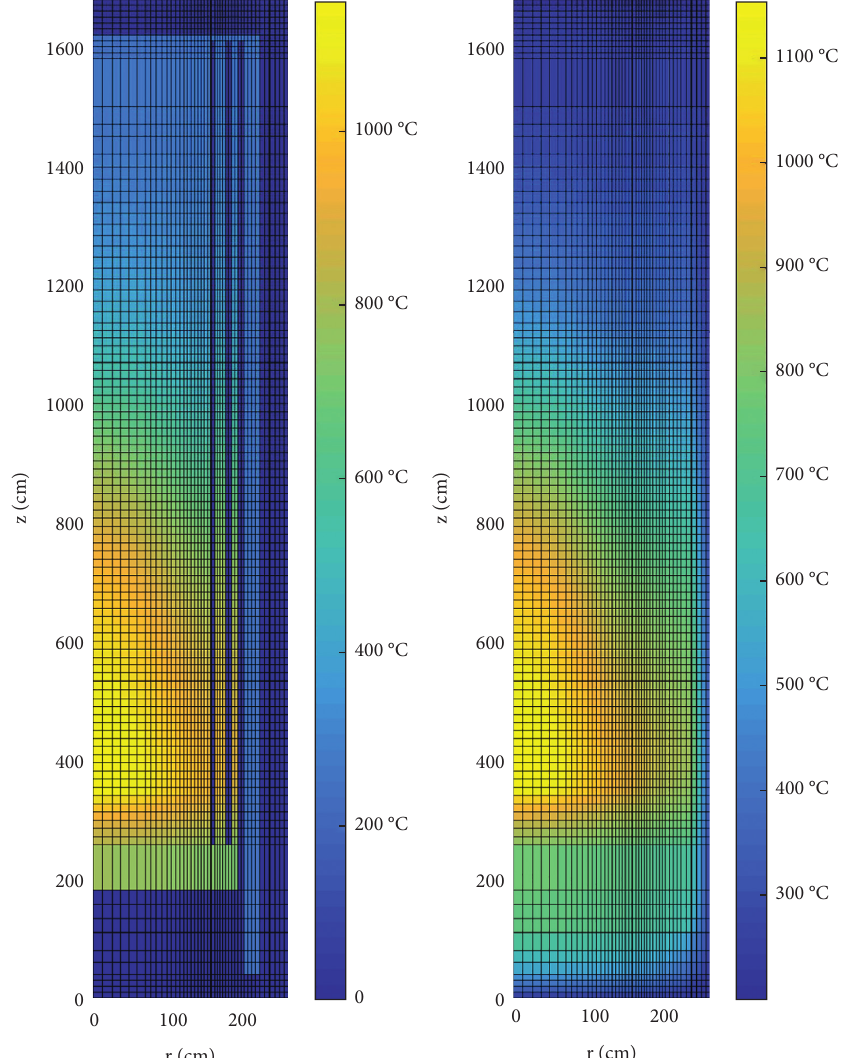
Figure 5: Simplified HTR-PM model fluid temperature and solid temperature in steady